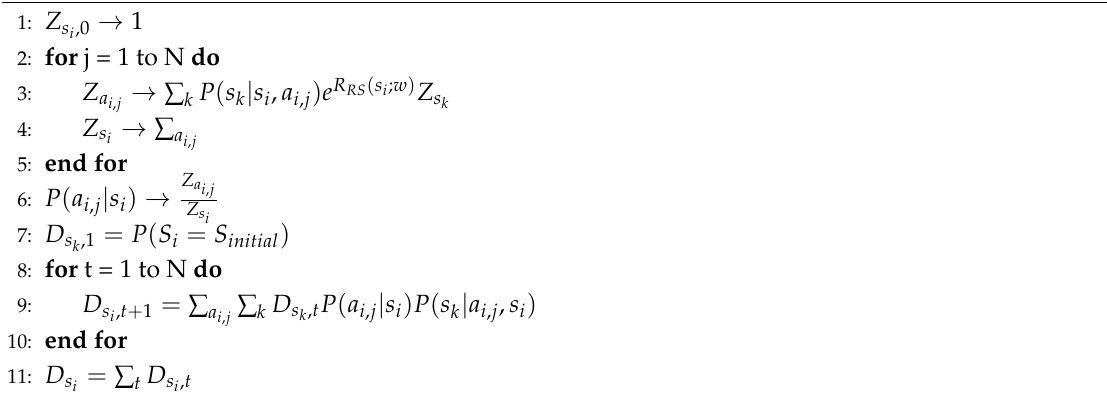
Algorithm 2 Approximate expected empirical feature